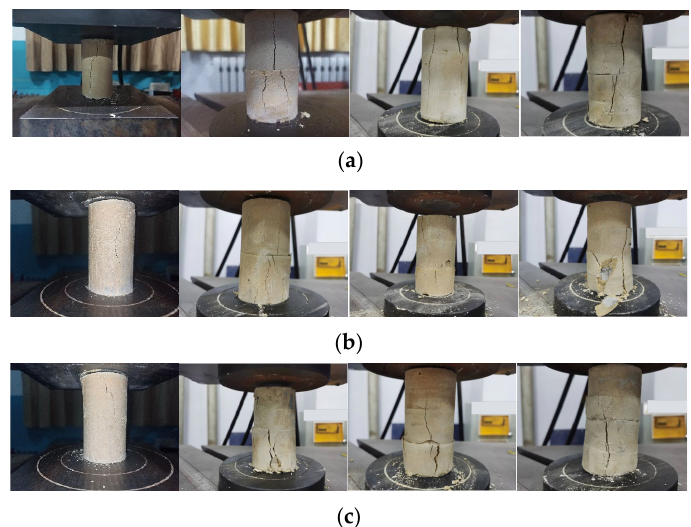
Figure 12. Failure modes of filling body specimens with different concentrations: ( a ) 66% filling body; ( b ) 68% filling body; ( c ) 70% filling body. ( b ) 68% filling body; ( c ) 70% filling